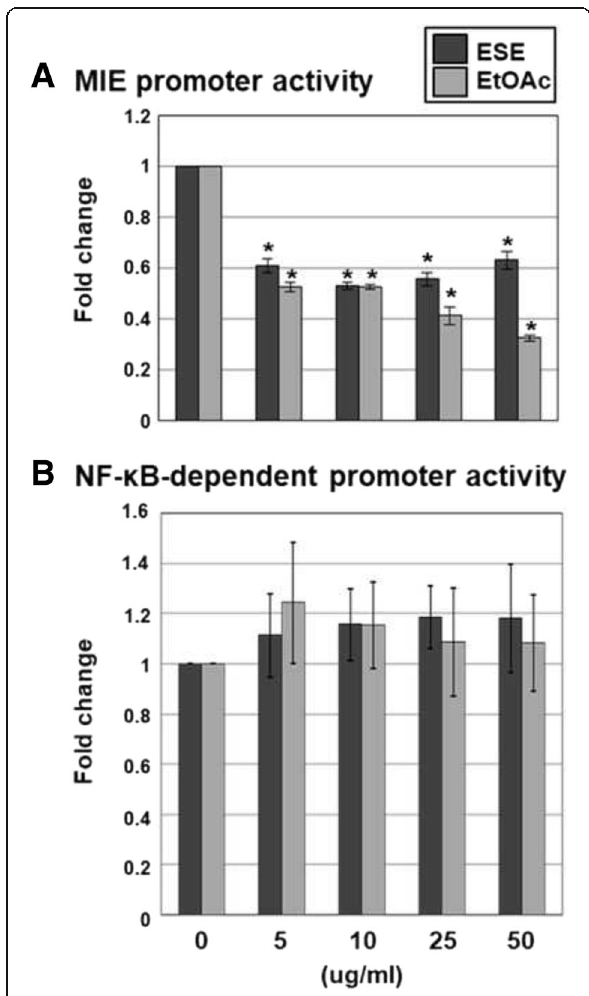
Fig. 6 Effects of the EtOAc fraction of ESE on HCMV MIE enhancer/ promoter. HEK293 cells were transfected with ( a ) HCMV MIE enhancer/promoter-driven firefly luciferase or ( b ) NF- κ B-dependent promoter-driven firefly luciferase plus control Renilla luciferase plasmids. Cells were treated with DMSO, ESE or the EtOAC fraction of ESE at concentrations of 5, 10, 25 or 50 μ g/ml, and luciferase activity was determined using a dual luciferase assay system. MIE enhancer/promoter- or NF- κ B-dependent promoter-driven luciferase activity was expressed in RLU by normalizing firefly luciferase activity with constitutive Renilla luciferase activity. To calculate relative luciferase activity, MIE enhancer/promoter- or NF- κ B-dependent promoter-driven firefly luciferase activity in the presence of DMSO was set as 1. Data represent the average of three independent experiments. (RLU, relative luciferase light unit) Significant difference between samples was determined based on P values obtained from Student ’ s t test (* P <